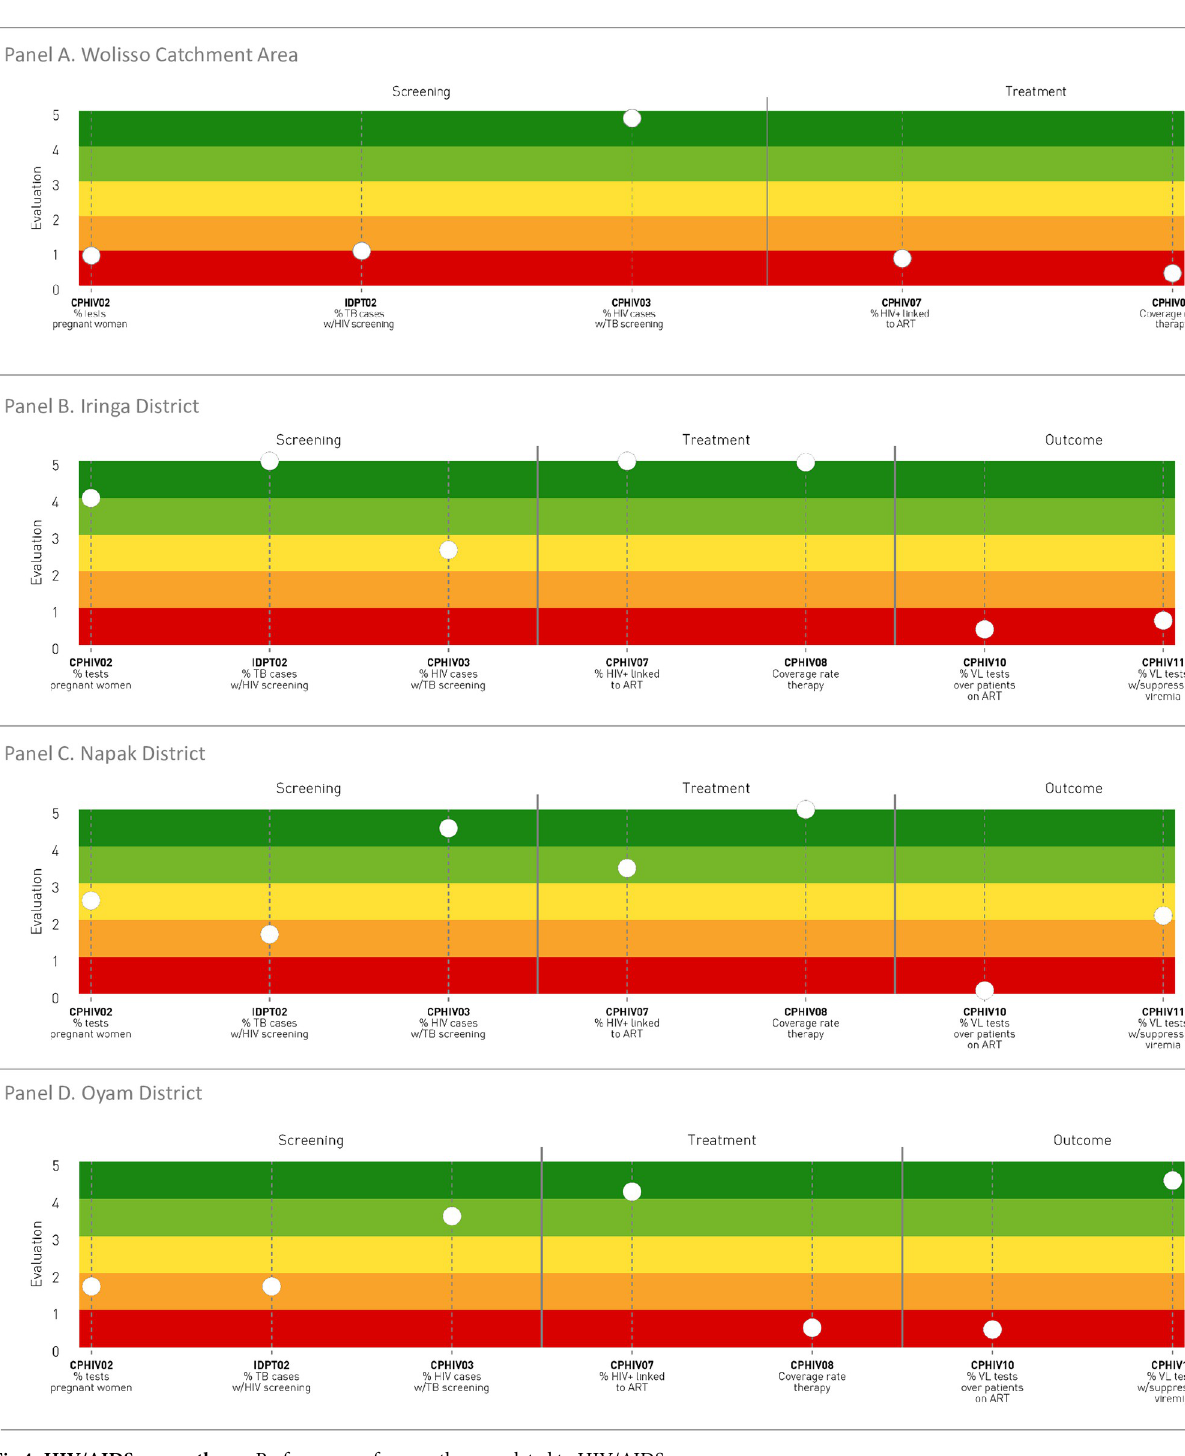
PLOS ONE | https://doi.org/10.1371/journal.pone.0266225 March 31,